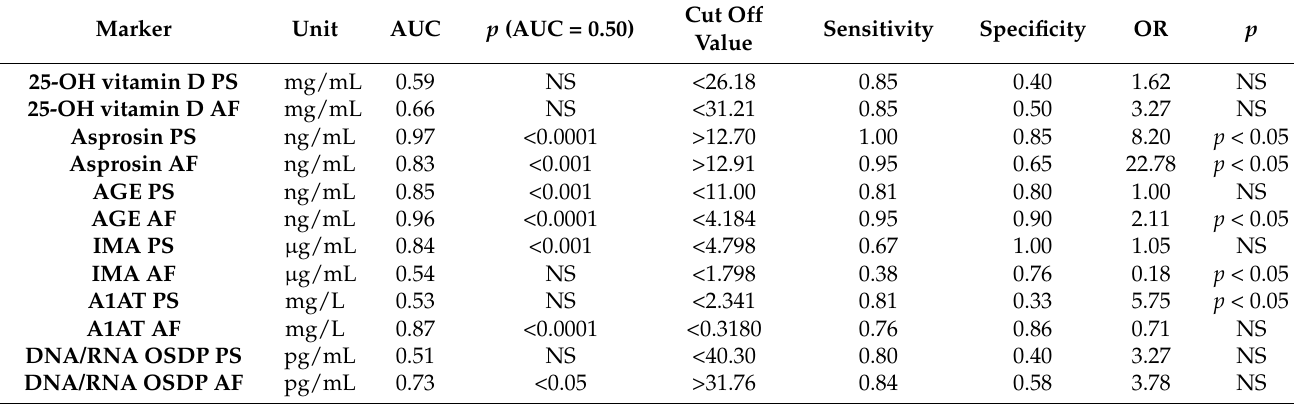
Table 2. Diagnostic criteria of the receiver operating characteristic (ROC) curve for the tested parameters.